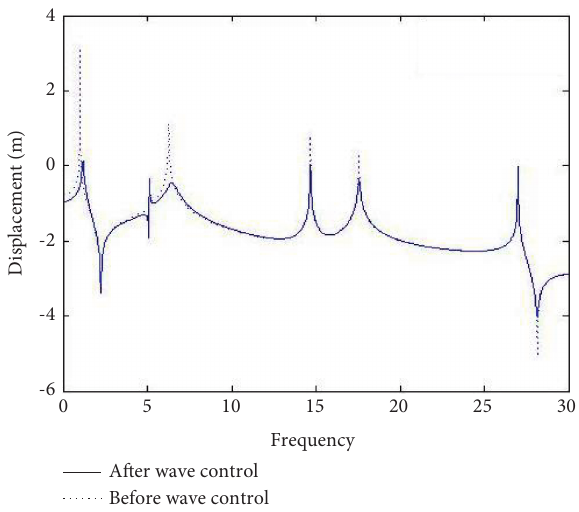
Figure 5: Frequency response before and after wave